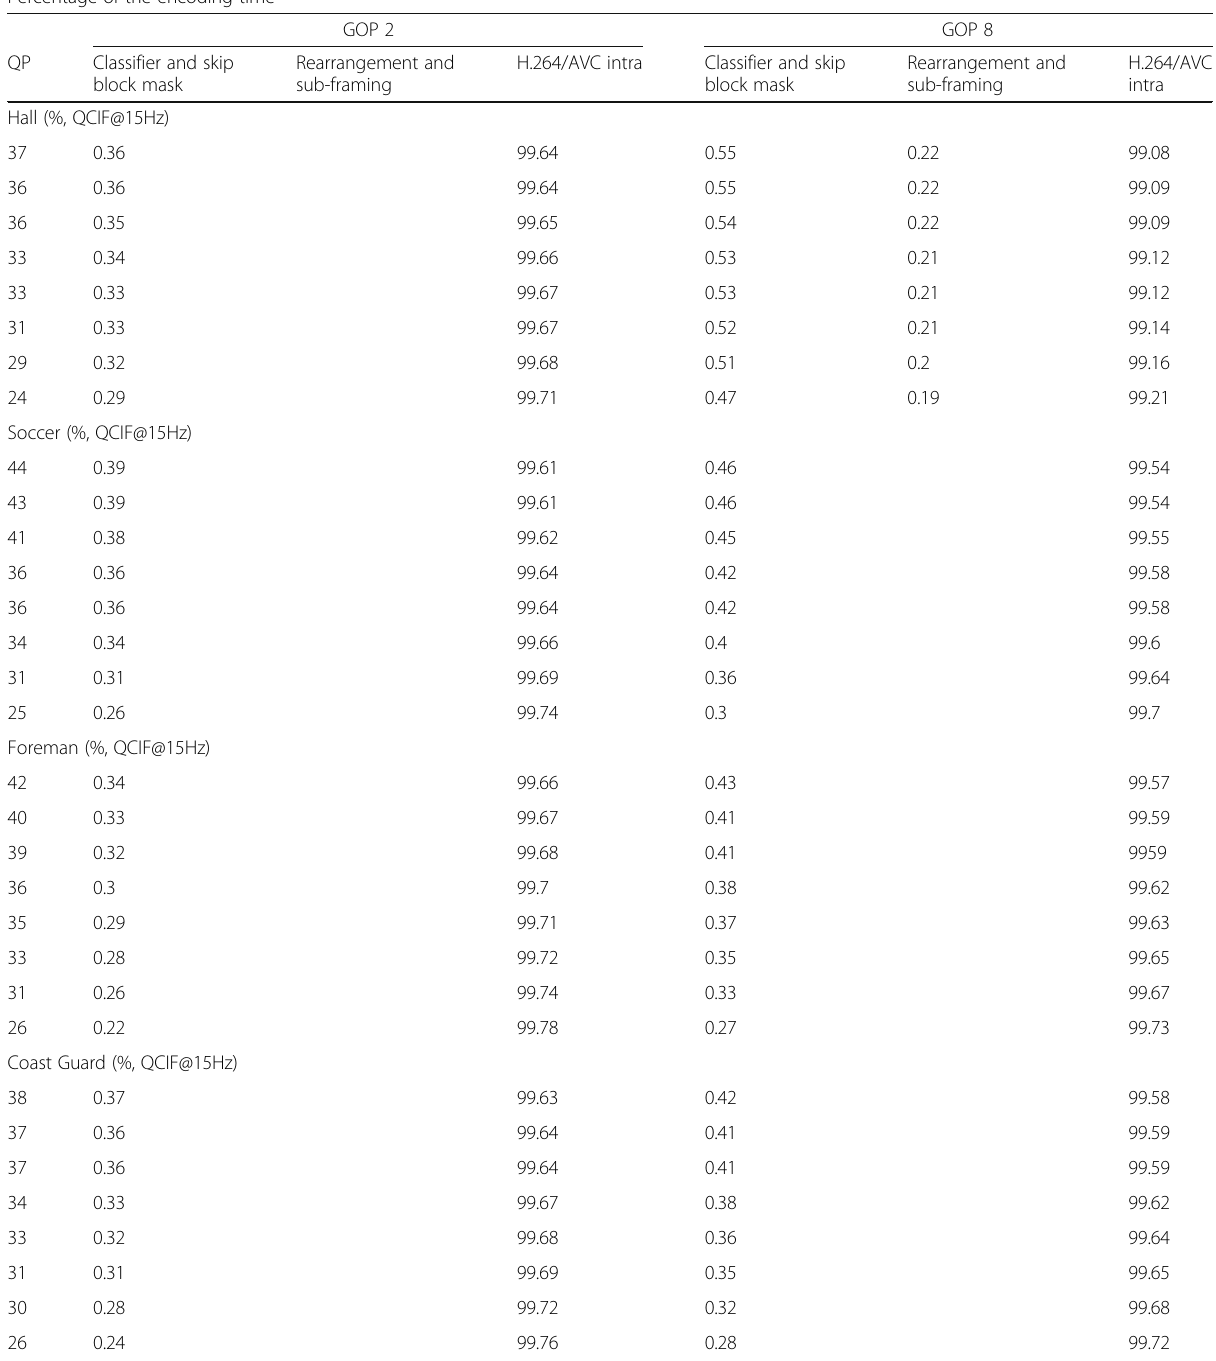
Table 3 The encoder time percentage of the proposed PB-based